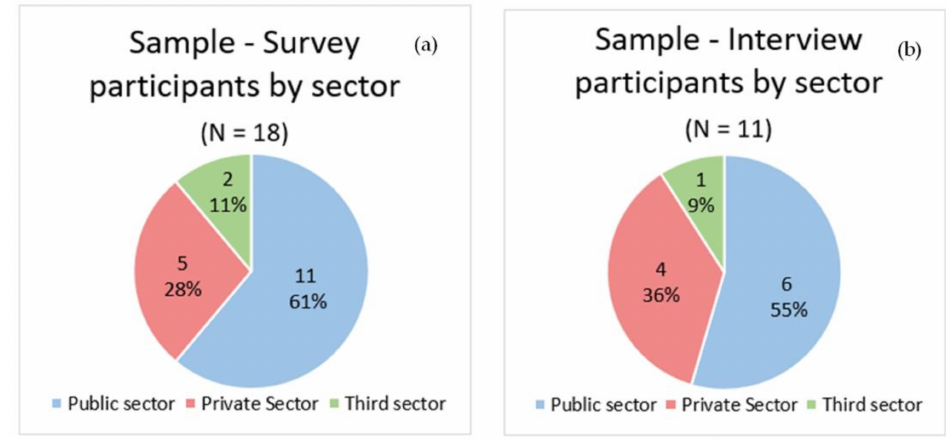
Figure 2. Sample of participants for ( a ) surveys ( b ) and